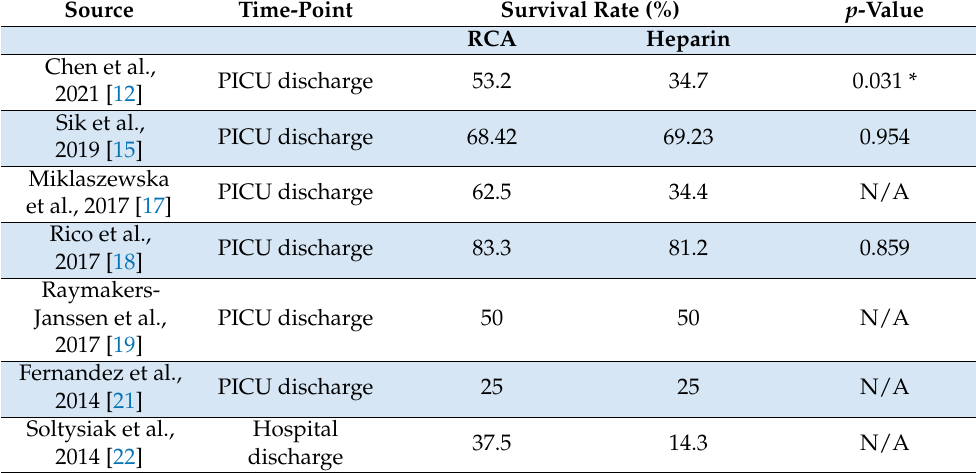
Table 6. Survival rate according to anticoagulant methods. RCA: regional citrate anticoagulation; *: statistically